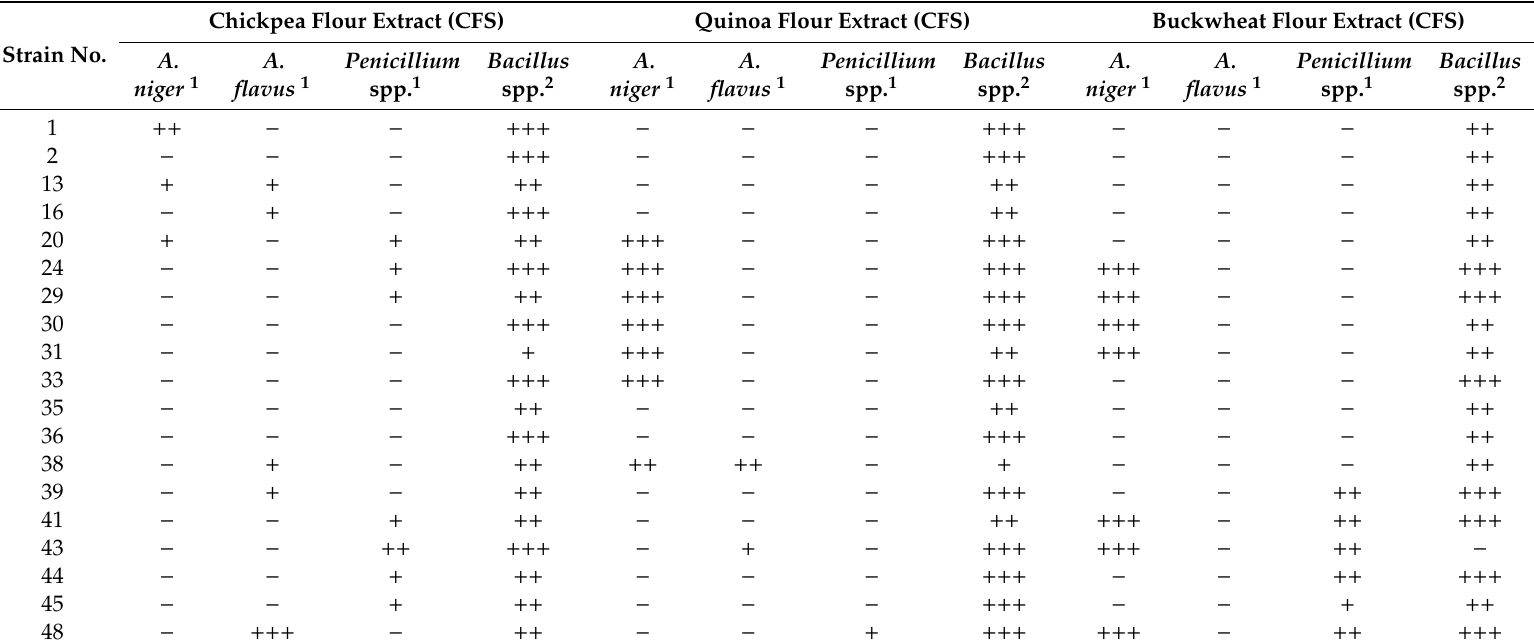
Table 3. Antimicrobial properties of the flour extracts fermented by the presumptive LAB strains.